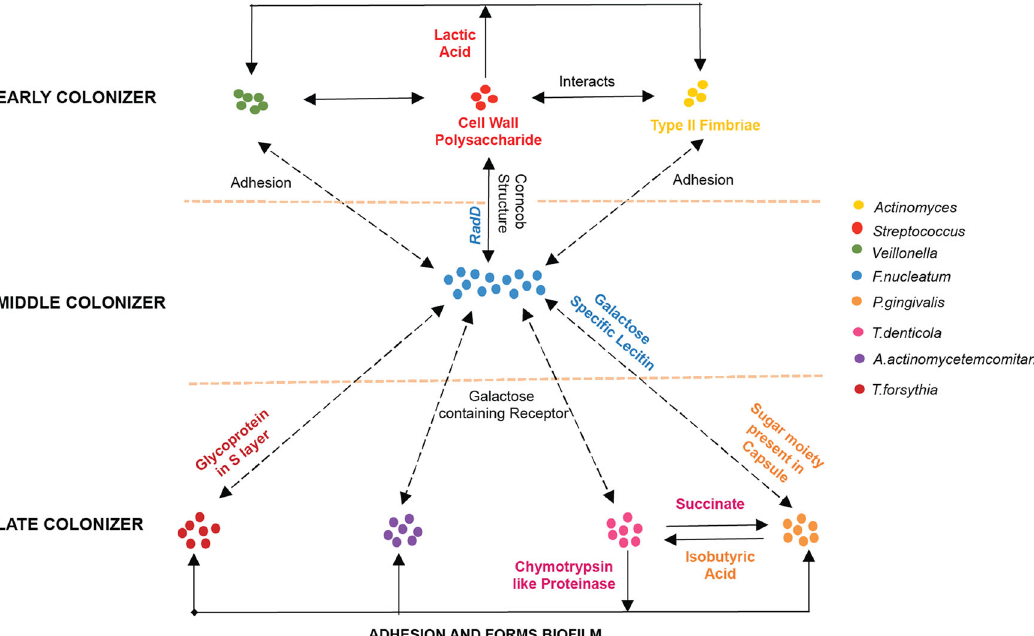
Fig. 6 Atherosclerotic plaque-associated bacteria form bio fi lm structures within the atherosclerotic plaque samples. During initial phase of bio fi lm formation, early colonizers — Veillonella , Streptococcus , and Actinomyces — interact to establish an initial microenvironment supporting each other with the help of metabolic products. These bacteria act as a platform for the middle colonizer F. nucleatum , which then completes the bio fi lm formation by providing an adhering platform for the late colonizers — T. forsythia , A. actinomycetemcomitans , T. denticola , and P.